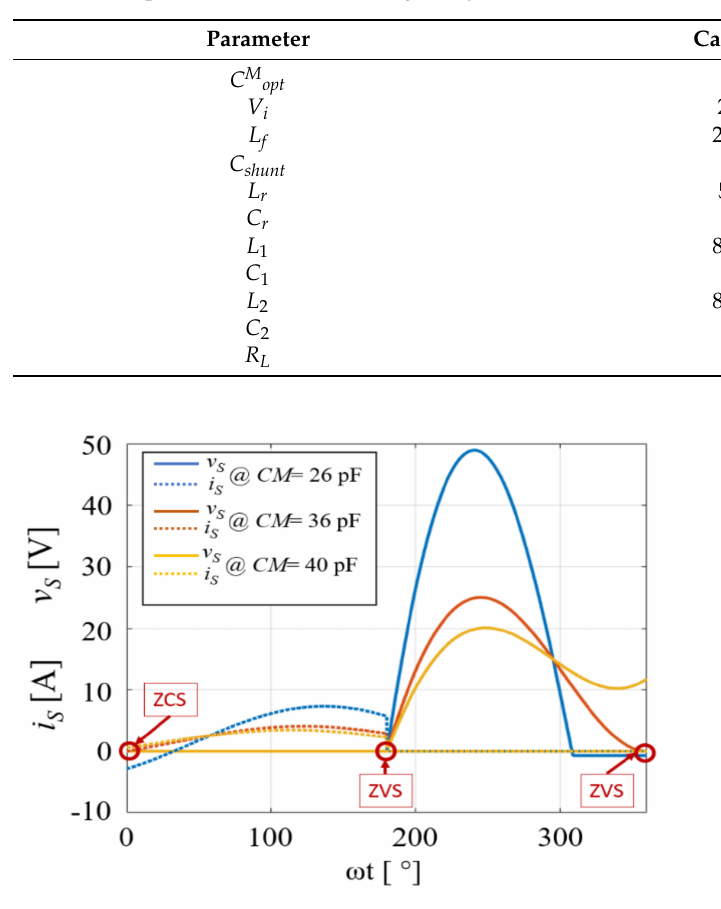
Figure 9. Voltage and current waveforms through the MOSFET for three different values of coupling capacitance C M